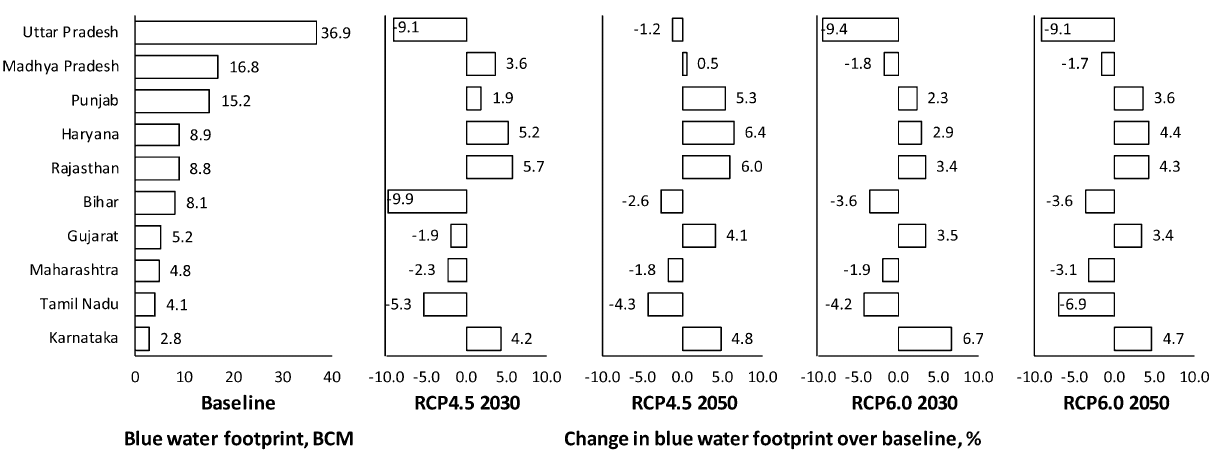
Figure 6. Blue WF of ten major states under baseline scenario and its variation under future climate change